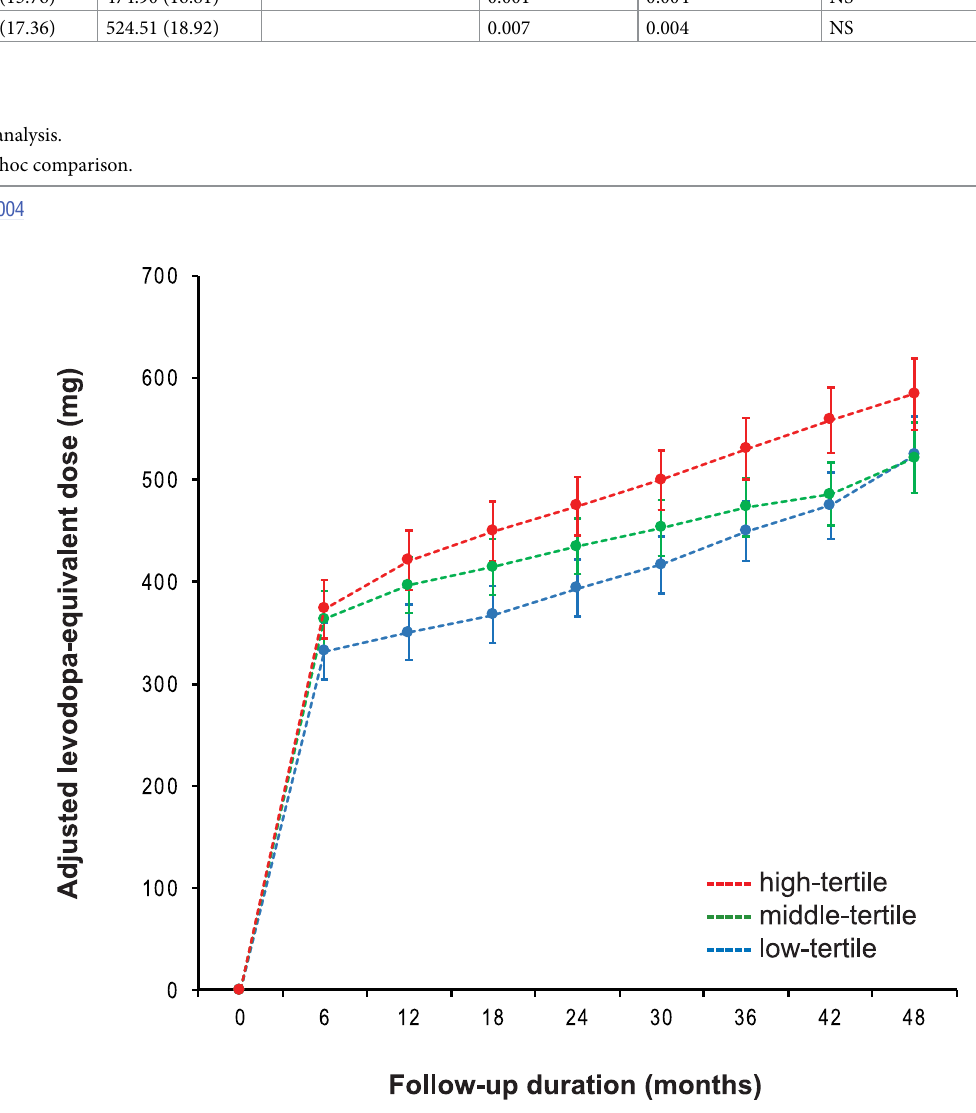
Fig 2. Longitudinal increases in levodopa-equivalent doses. High-tertile group received higher levodopa-equivalent doses for symptom control than low-tertile group. Middle-tertile group received lower LEDs than high-tertile group after follow-up of three years or longer. There was no significant interaction between the tertile groups and time in the mixed model.